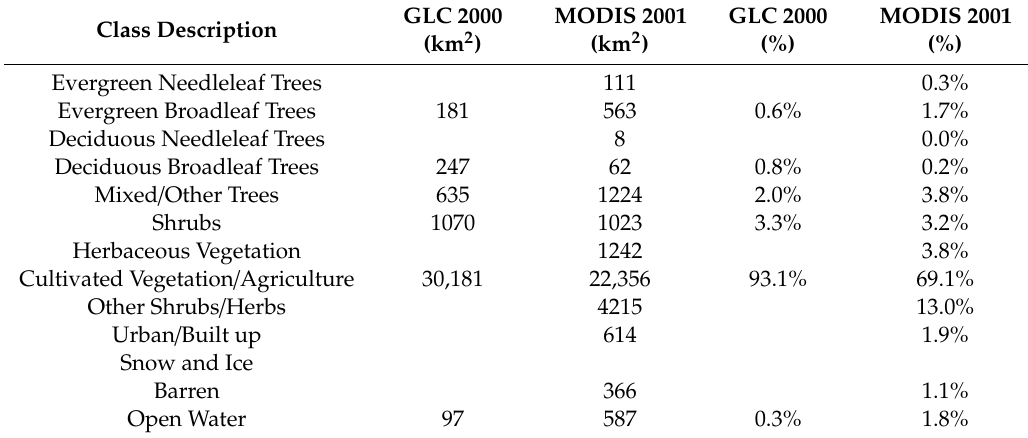
Table 1. Quantitative comparison of the GLC 2000 and the MODIS 2001 land cover products for the larger Mekong Delta and Tonle Sap Lake area, displayed in km 2 and